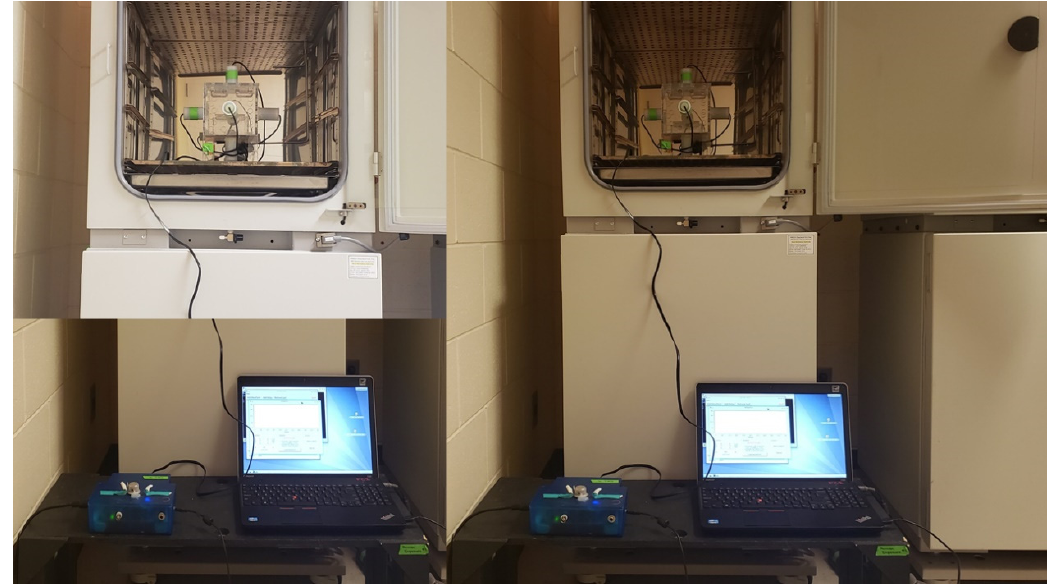
Figure A2. Photographic representation of the 4-D application geometry with corresponding computer generated patterned EMF (computer) and custom built digital-to-analog converter (DAC; blue box).